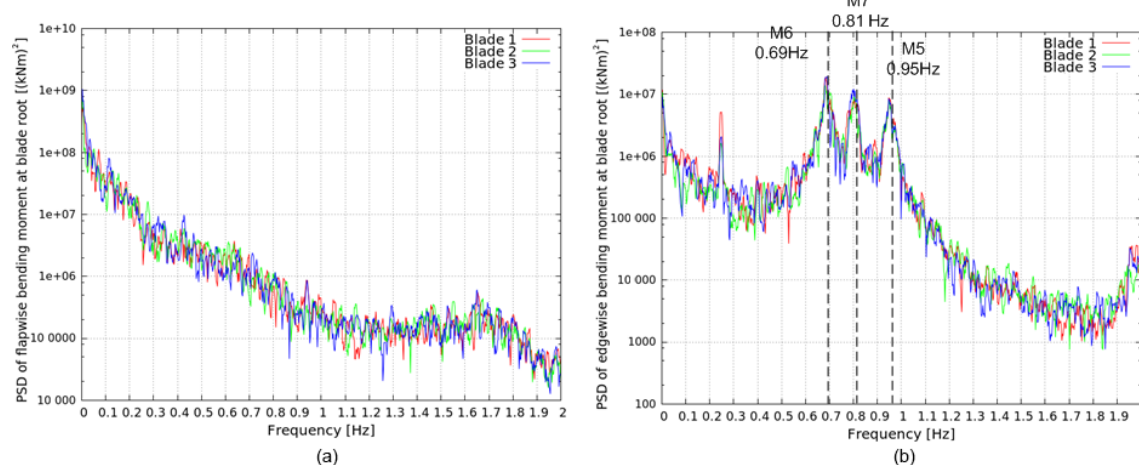
Figure 17. (a) PSD of the flapwise bending moment at the blade root and (b) PSD of the edgewise bending moment at the blade root; U = 42 . 5ms − 1 and yaw = 0 ◦ .